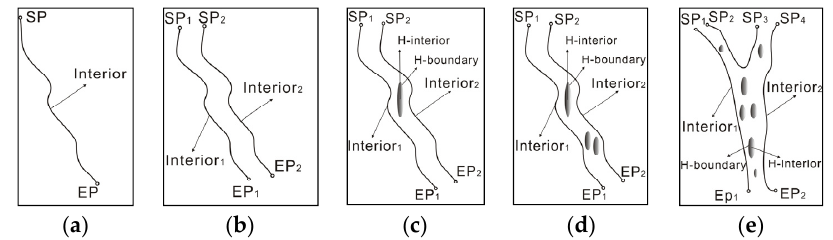
Figure 3. GIS models of river planforms. ( a ) Single-line model; ( b ) double-line model; ( c ) double line one-region model; ( d ) double line several-regions model; ( e ) three or more lines with several regions model.